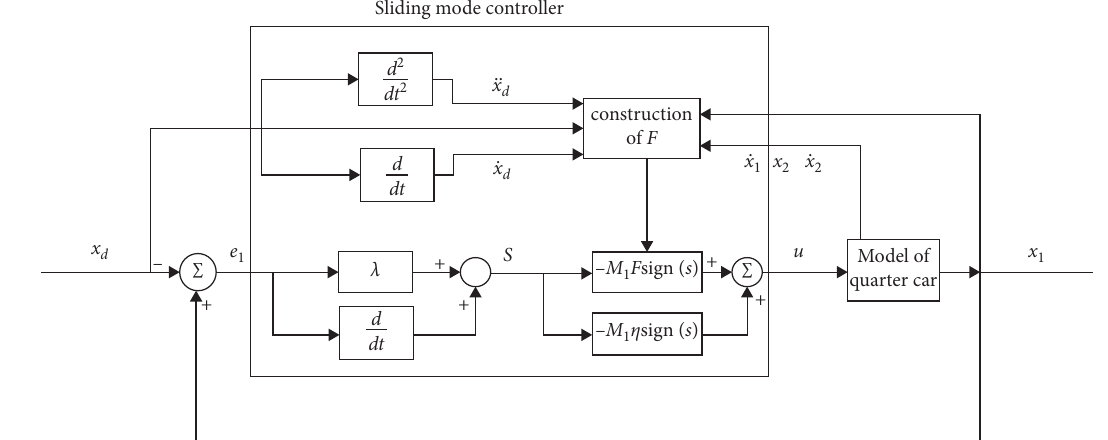
Figure 3: Block diagram of determining feedback control. Table 1: Suspension parameters